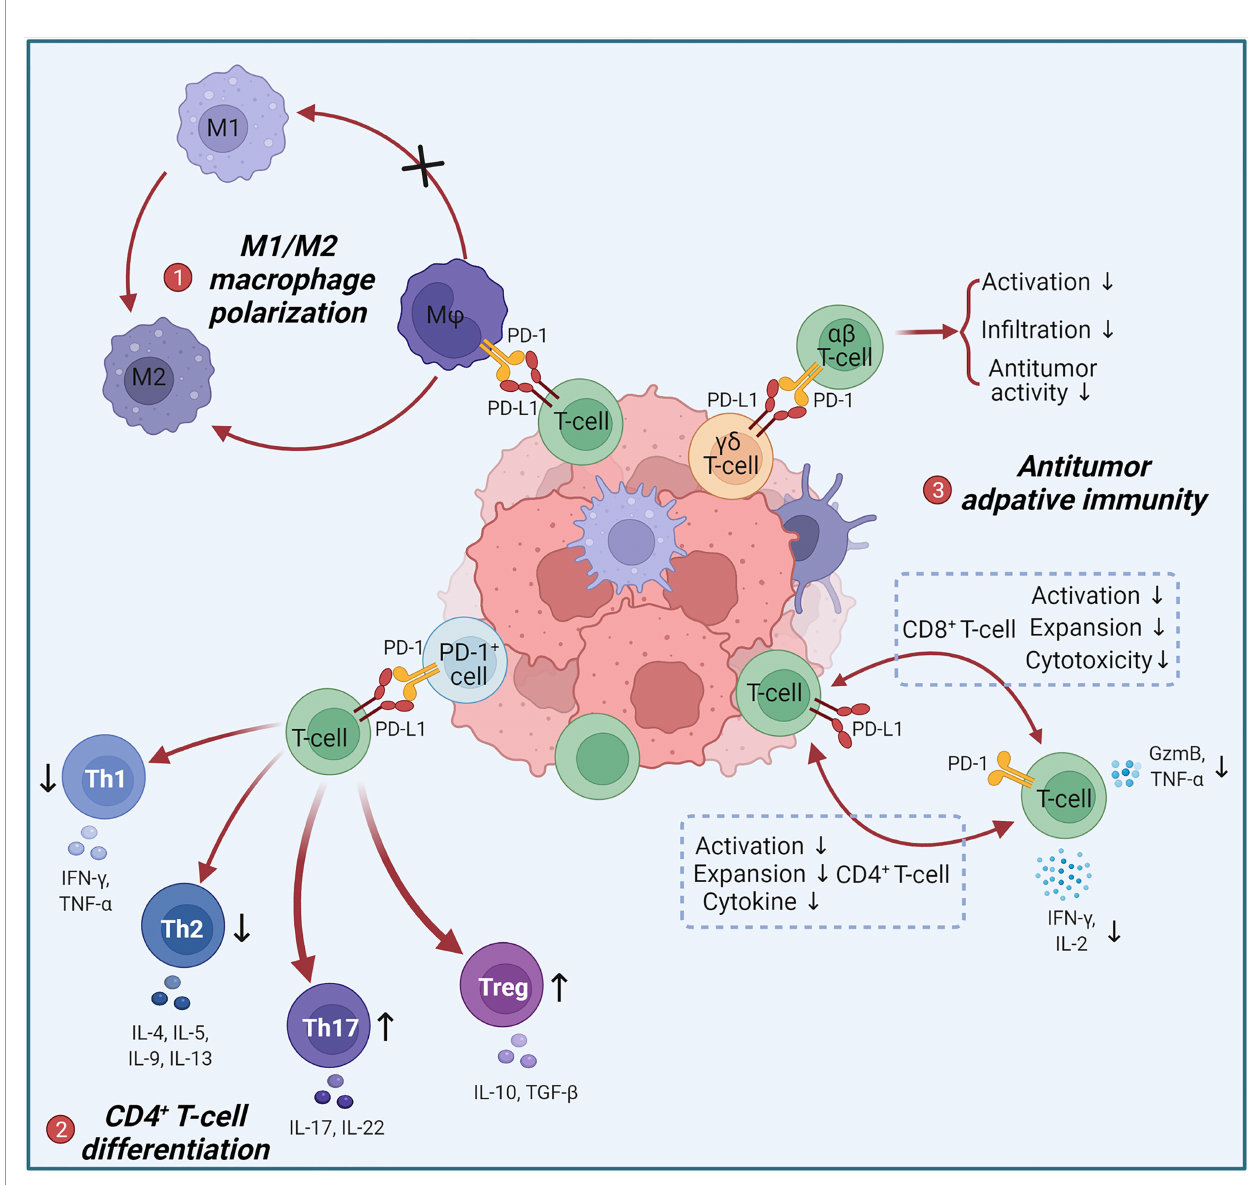
FIGURE 1 | Negative regulation of anti-tumor immune responses by T-cell intrinsic PD-L1. (1) Tumor-in fi ltrating PD-L1 + T-cells act on intratumoral PD-1 + macrophages to induce M2 polarization. M2 can promote tumor progression. (2) PD-1 + cells act on PD-L1 + T-cells to limit the differentiation of Th1 and Th2 and promote the differentiation of Th17 and Tregs, leading to an increase in pro-tumor immunosuppressive factors such as IL-10, IL-17 and TGF- b . (3) PD- L1 + T-cells and PD-1 + T-cells achieve bidirectional signaling through PD-1/PD-L1 interactions, resulting in bidirectional immunosuppression: inhibition of CD4 + T-cells activation, expansion and cytokine secretion; inhibition of CD8 + T-cells activation, expansion and cytotoxicity. PD-L1 + gd T-cells suppress the activation, intratumoural in fi ltration and antitumor activity of ab T-cells via the PD-L1/PD-1